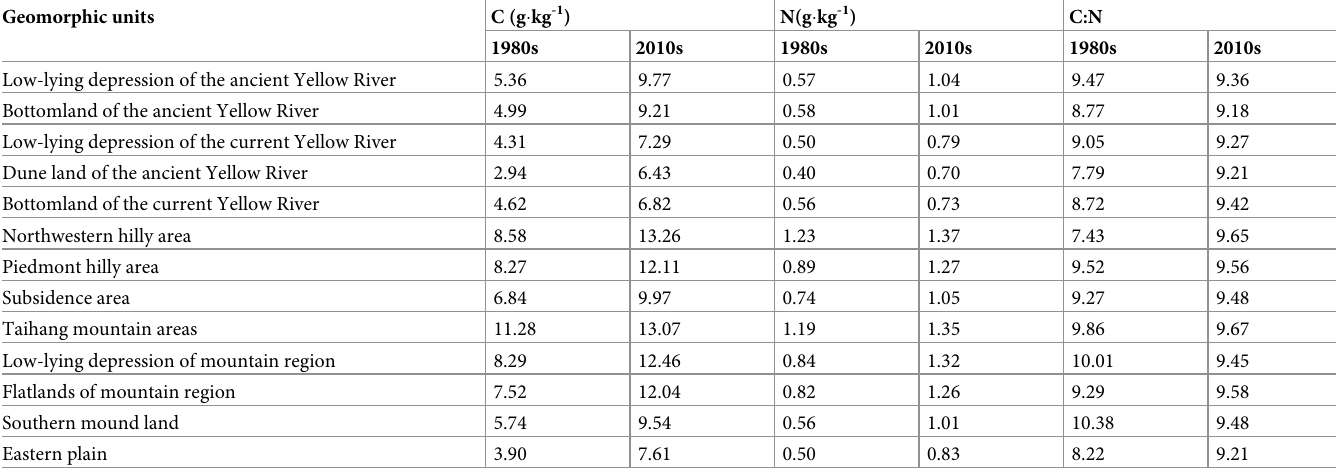
Table 5. Soil C, N contents and C:N ratio in different geomorphologic units. Geomorphic